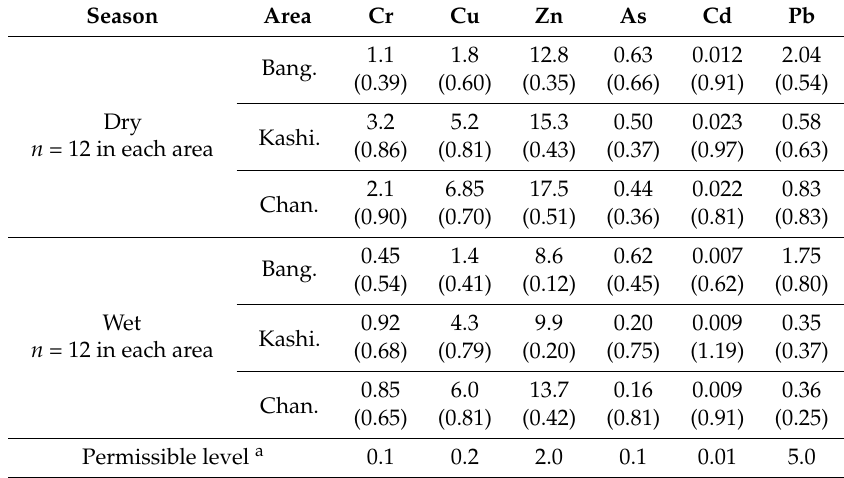
Table 1. Mean heavy metal concentration of irrigation water (mg/L) and coefficient of variation of concentration (in parentheses) in dry and wet seasons in the three